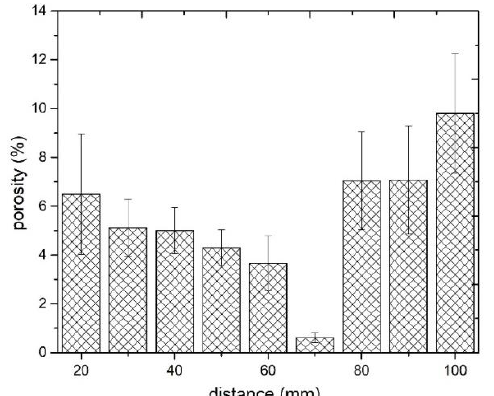
Figure 4. The porosity of the cold-sprayed titanium coatings versus the standoff distance (20 −100